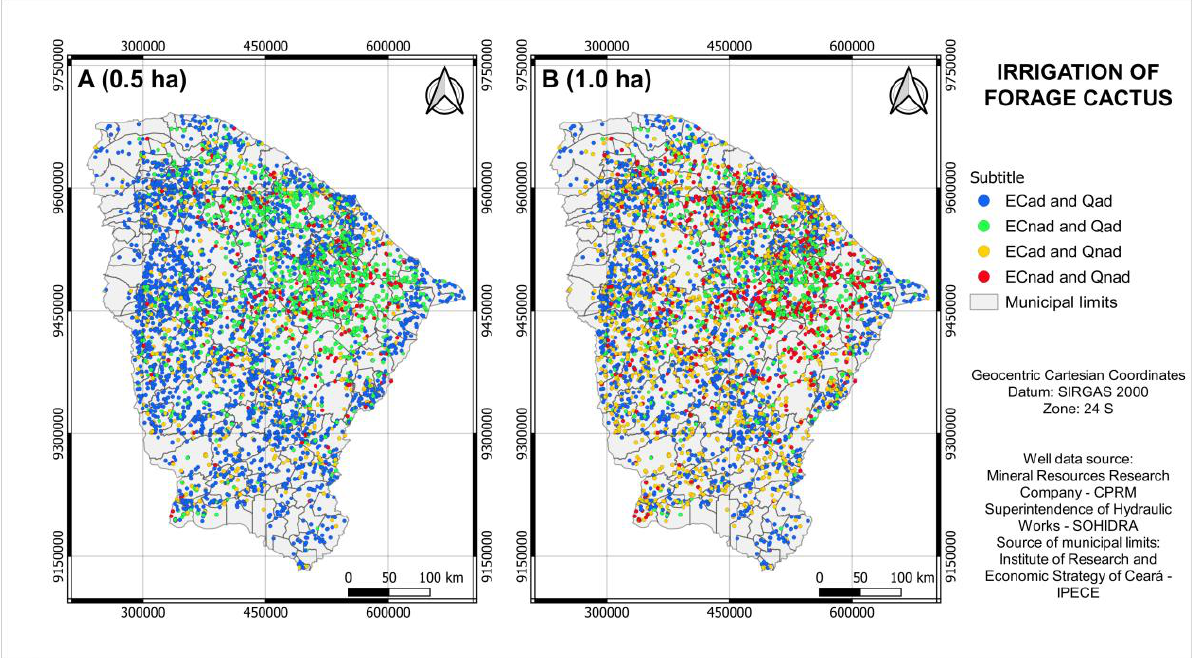
Figure 5. Potential of brackish groundwater in the State of Ceará (Northeast Brazil) for full irrigation of forage cactus in 0.5 ha ( A ) and 1.0 ha ( B ), based on the threshold electrical conductivity of the